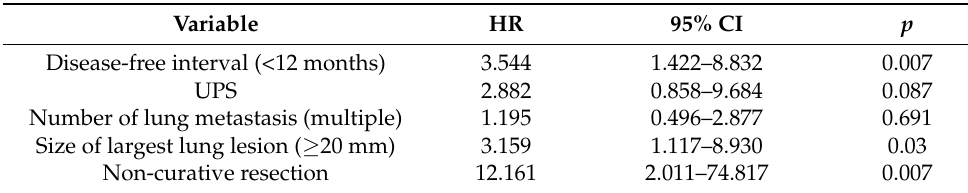
Table 3. Multivariate Analyses of Factors Associated with Disease-specific Survival after Pul- monary Metastasectomy. Variable HR 95% CI p Disease-free interval (<12